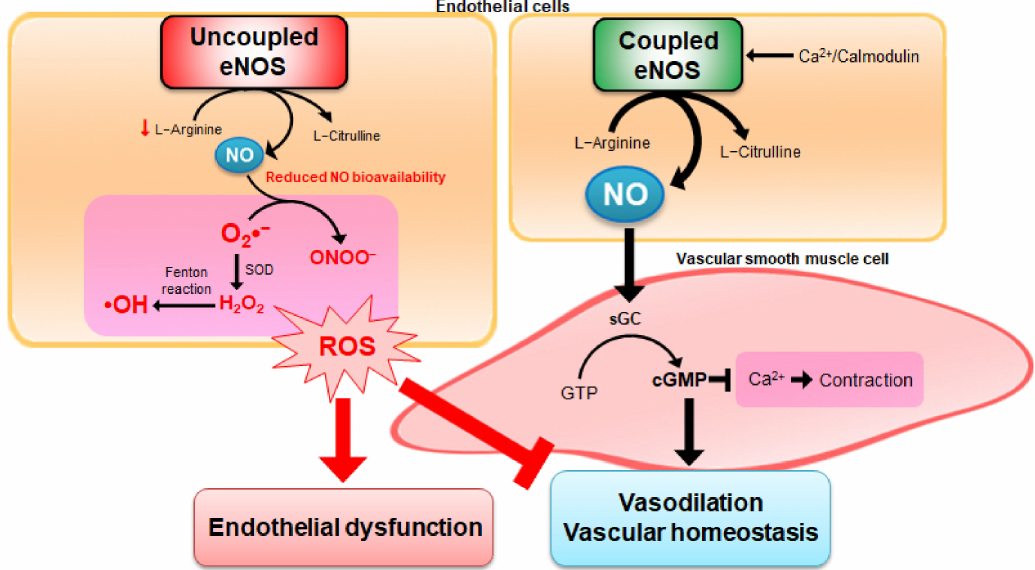
Figure 4. Endothelial dysfunction via modulation of eNOS uncoupling. Coupled eNOS utilizes L -arginine to produce NO and L -citrulline predominantly rather than ROS. NO plays an important role in the vasodilation of vascular smooth muscle cells (VSMCs) to maintain vascular homeostasis through the cyclic guanosine monophosphate (cGMP)-dependent signaling cascade. In pathological situations, eNOS becomes dysfunctional and produces superoxide anions (O 2 •− ) rather than NO. Superoxide anions are dismutated to form hydrogen peroxide (H 2 O 2 ) by superoxide dismutase (SOD), and are used to generate hydroxyl radicals ( • OH) by the interaction with ferrous iron and H 2 O 2 through Fenton reaction. Furthermore, the interaction between NO and superoxide anions leads to the formation of peroxynitrite (ONOO − ), resulting in ROS production with subsequent endothelial dysfunction. Endothelial dysfunction is characterized by decreasing bioavailability of eNOS-derived NO, which results in impaired endothelium-dependent